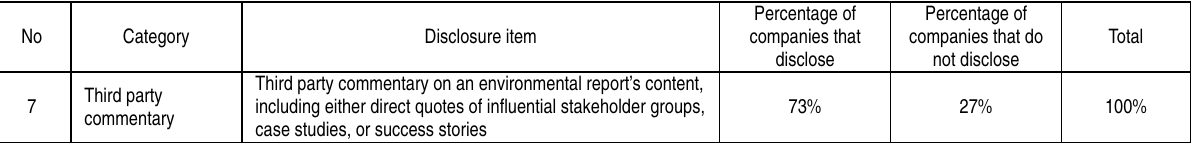
Table 4. Disclosure of third party commentary, case studies, success stories, international accreditation